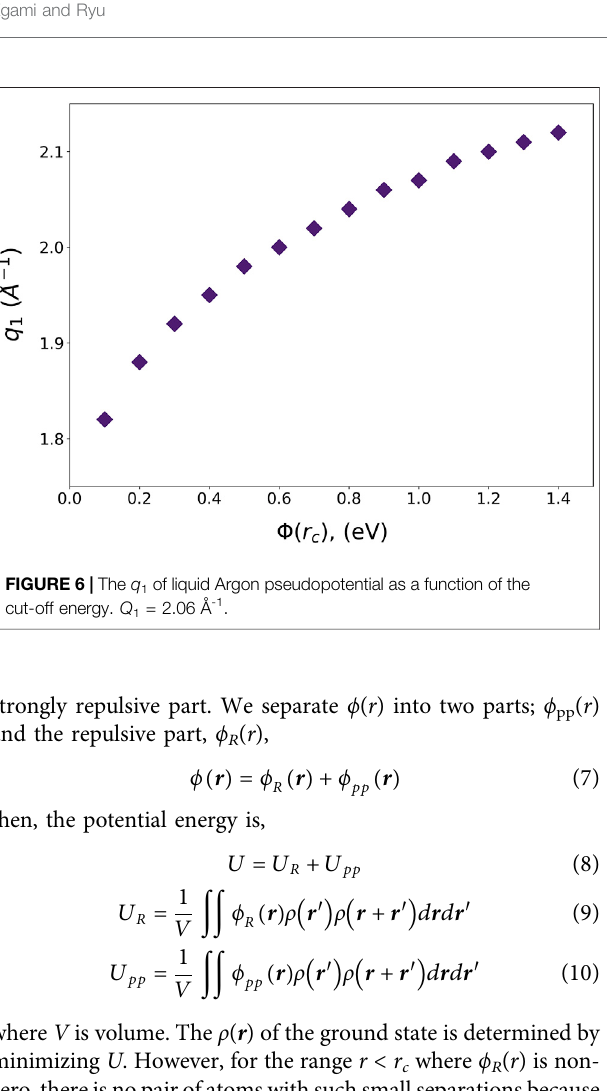
Figure 6 . The value of Q 1 decreases with increasing temperature, down to 1.93 Å − 1 at T = 100 K. A minimum in ϕ pp ( q ) at q 1 implies that a density wave with q 1 would be energetically preferred.